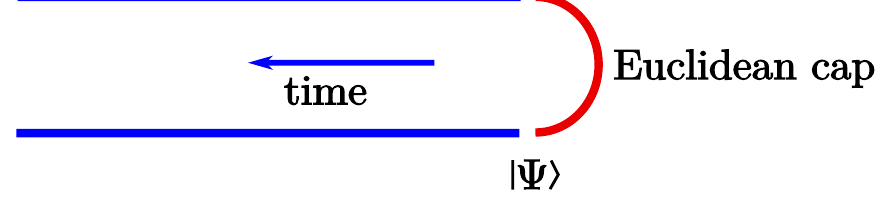
Figure 3 . The red region represents a Euclidean \cap" that creates a state j (cid:9) i . This state is then propagated in QFT on R + q R + using the Lorentzian evolution e (cid:0) itH . For the 1